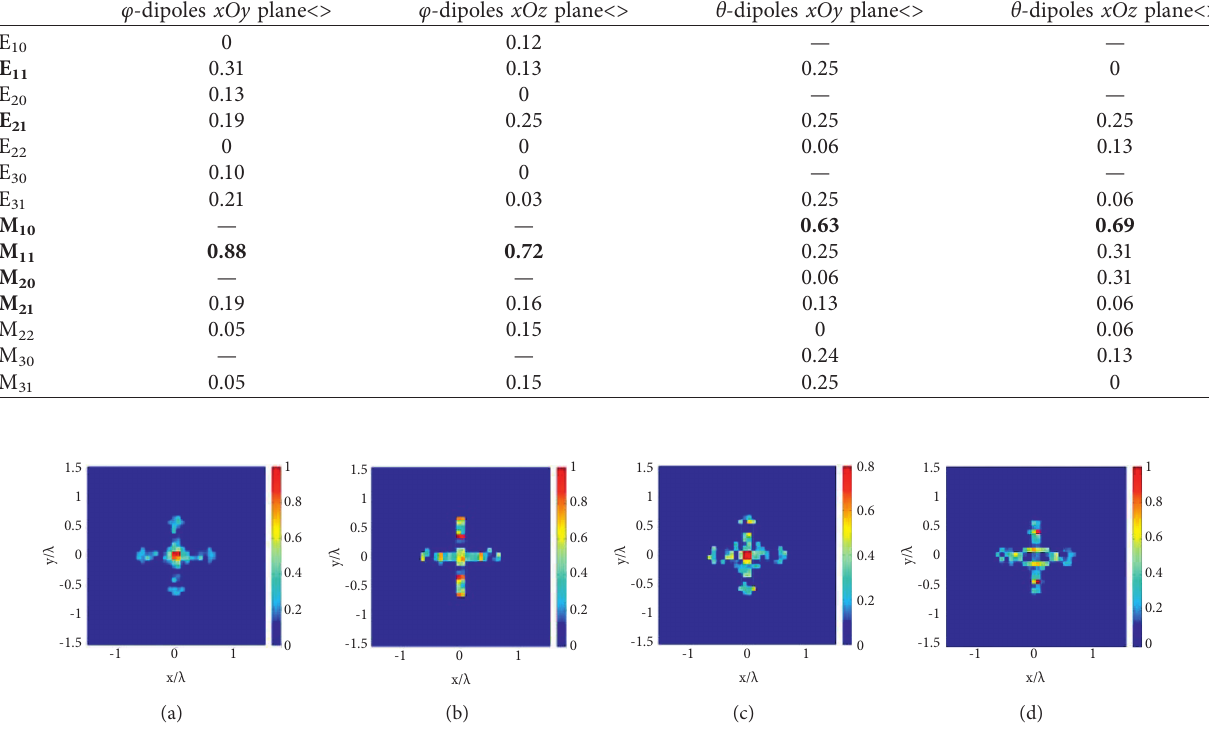
Figure 6: Cross-shaped PEC target images obtained using multiple harmonics. (a) xOy plane and φ -oriented dipoles. (b) xOz plane and φ -oriented dipoles. (c) xOy plane and θ -oriented dipoles. (d) xOz plane and θ -oriented dipoles. The adopted signal-to-noise ratio was SNR � 10 dB. Table 2: Parameters η and η calculated for the cross-shaped PEC 1 2